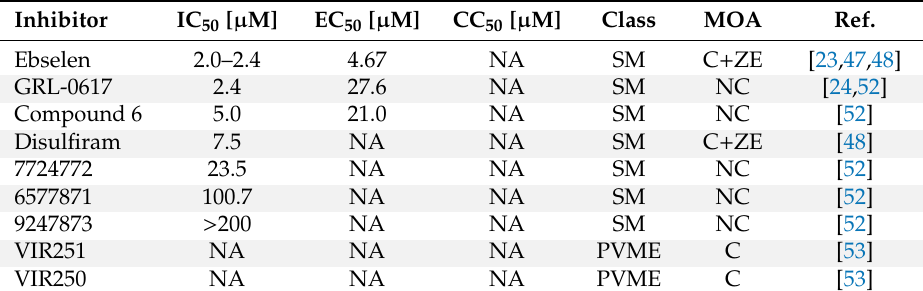
Table 3. Inhibitors of SARS-CoV-2